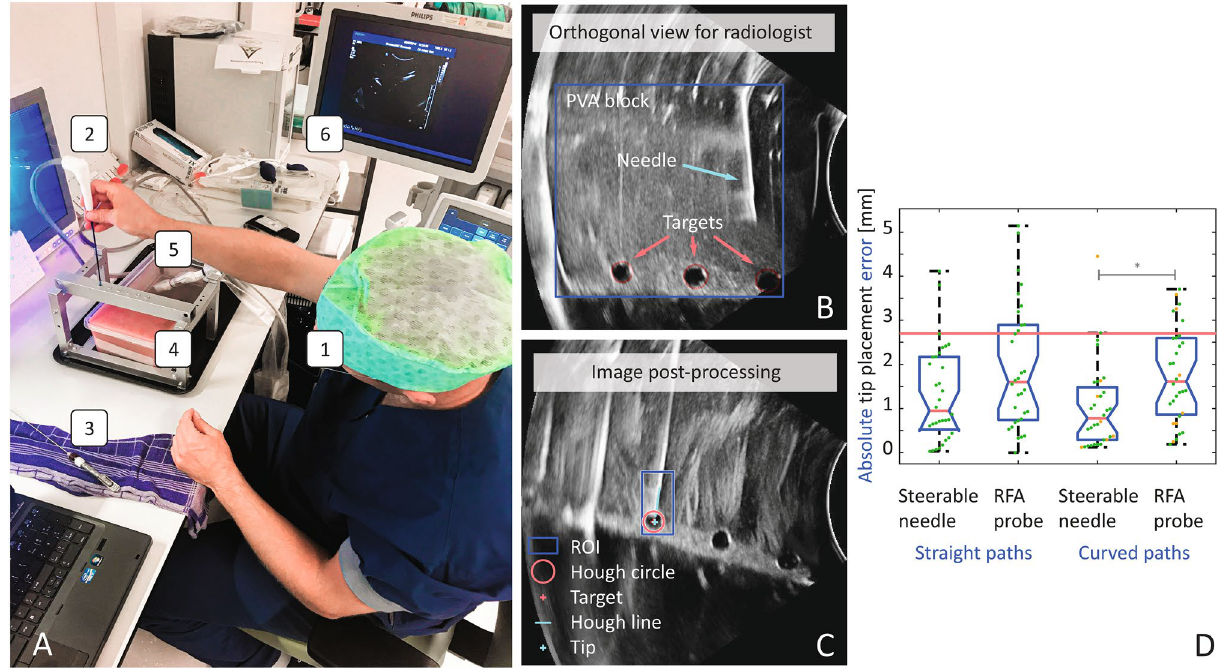
Figure 2. Image of the experimental platform ( A ), showing the interventional radiologist (1), RFA probe (2), steerable needle v1 (3), and PVA phantom (4), with a trocar bridge to control the insertion location, needle alignment and steering task. The ultrasound probe (5) is manually controlled to visualise insertions on-screen (6). Typically, radiologists pressed the probe to the side of the PVA specimens, yielding an orthogonal view ( B ). Ultrasound images were stored and processed, using a region of interest (ROI) and Hough transforms to estimate target, needle and tip locations ( C ). Tip placement errors for straight and curved paths are shown by boxplots and individual data points ( D ). The asterisk indicates a Wilcoxon rank sum test difference (α = 0.05). Errors after manual path correction steps are visualised in orange. The red line indicates an acceptance threshold error of 2.7 mm, which was the mean position error accepted by a group of 125 interventional radiologist 4 error (Fig. 2C) and times required for needle placement and instrument switching were registered. In addition, the effect of the instrument switch on the position error was registered, as this error was expected to change due to differences in flexural rigidity of the steerable needle and RFA probe. Mean and standard deviation (SD) of times required to place needles and switch instruments (remove stylet and insert RFA probe) were 16 ± 8 s and 24 ± 7 s for straight paths. In case of curved paths, the same steps took 22 ± 17 s and 22 ± 9 s. Manual path corrections using the same tissue entry point were allowed and used for seven insertions (shown by orange datapoints in Fig. 2D), requiring two (n = 3), three (n = 3) or four (n = 1) tries to reach the target. This only occurred for curved needle paths. Absolute tip placement errors are shown in boxplots in Fig. 2D. They were evaluated using a Kruskal–Wallis test and Wilcoxon rank sum tests (α = 0.05). The mean and SD of steerable needle placement errors along straight and curved paths were 1.3 ± 1.1 mm and 1.0 ± 1.0 mm, respectively. After the instrument switch, the RFA probe position errors were 1.9 ± 1.4 mm and 1.8 ± 1.1 mm, respectively. The Kruskal–Wallis test indicated a difference between groups (p = 0.005). The Wilcoxon rank sum tests located a difference in the curved-path placement of steerable needles and RFA probes (p = 0.002), i.e. caused by switching of instruments in the curved-path cases. Differences were not seen for straight path insertions (p = 0.07) or for curved and straight path placement using the steerable needle (p = 0.33). Evaluation part II: tissue damage after needle steering. The aim of the second part of the functional evaluation was to compare cross-sectional areas of puncture holes after straight-path and curved-path insertion, with the steerable needle (v2) and RFA probe (Fig. 3A). This metric served to quantify damage caused by steering forces exerted on tissue. It should be noted that the RFA probe is smaller (cross-sectional area of 1.96 mm 2 ) and fits within the concentric tube of the v2 steerable needle (2.54 mm 2 ). A comparable analysis of cross-sectional areas was used to demonstrate that tissue damage can be reduced in duty-cycling based steering of bevel-tipped needles by using bidirectional rotations, i.e. avoiding wind-up of tissue 20 . Needle exit point coordinates and path curvatures for the insertions in liver explants are shown in Fig. 3B. The fits illustrate the median constant radius of curvature arc for each experimental condition. Deflections